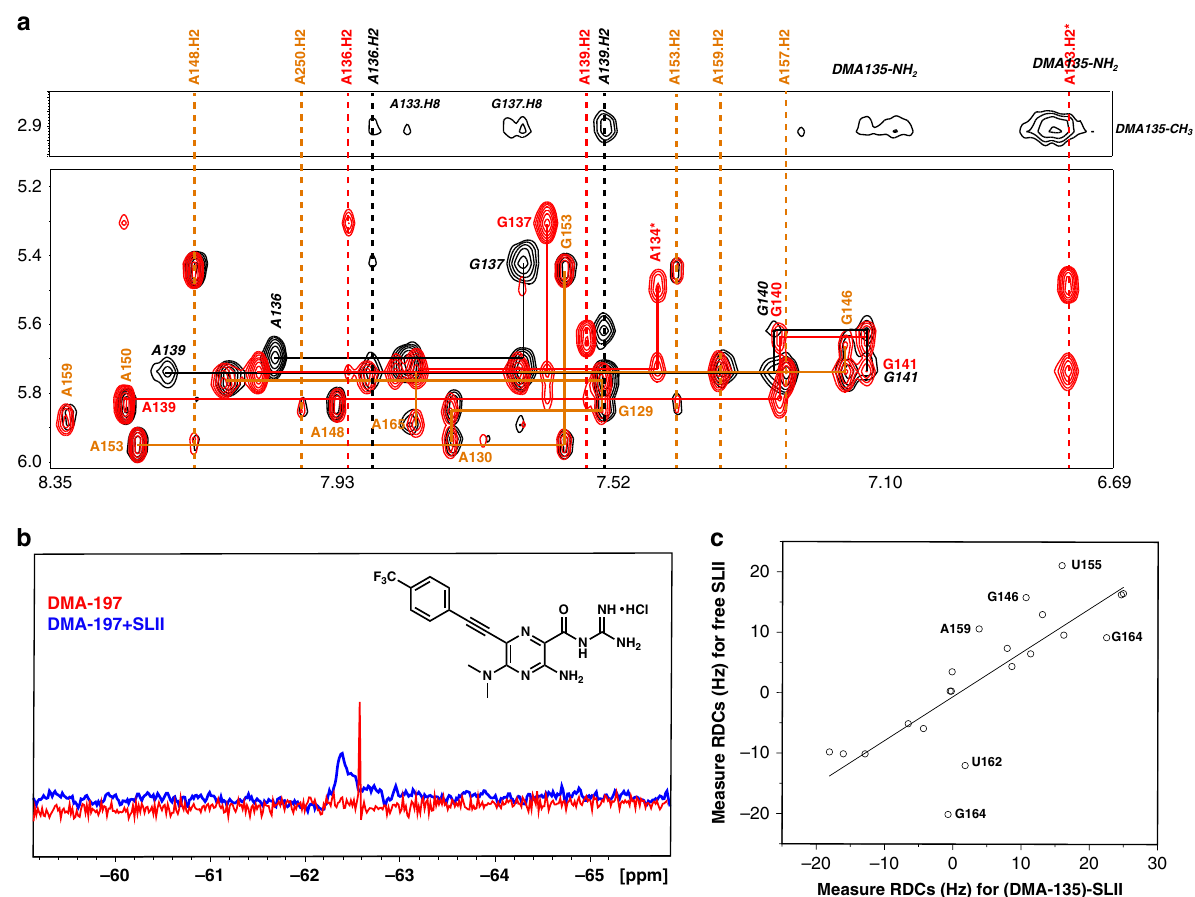
Fig. 4 DMA-135 changes the local and global structure of the EV71 SLII IRES domain. a Overlay of 1 H- 1 H NOESY spectra ( t m = 200 ms) of free SLII (red) and the (DMA-135)-SLII complex (black). The orange lines (solid and dashed) indicate NOE spin systems and chemical shifts that are identical between free SLII and the (DMA-135)-SLII complex. The black lines (solid and dashed) indicate NOE spin systems and chemical shifts of SLII within the complex that are signi fi cantly different from those of free SLII (indicated by red solid and dashed lines). Selected region of the 1 H- 1 H NOESY spectrum of the (DMA-135)- SLII complex showing intermolecular and intramolecular NOEs between methyl protons on DMA-135 and nucleobases of SLII. b 1D 19 F NMR spectra of DMA-197 in the absence (red) and presence of SLII at 1:1 complex (blue). c Correlation plot showing agreement between measured RDCs of free SLII and SLII within the DMA-135 complex. All NMR spectra were collected at 900 MHz in 10 m M K 2 HPO 4 , 20 m M KCl, 0.5 m M EDTA, and 4 m M BME (pH 6.5) D 2 O buffer at